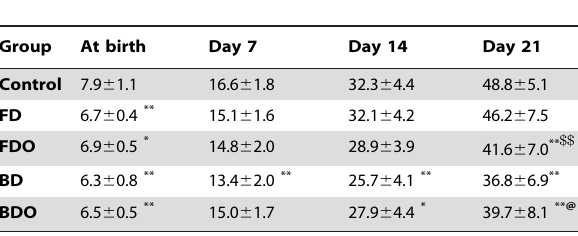
Table 3. Average pup weight (g) in different groups